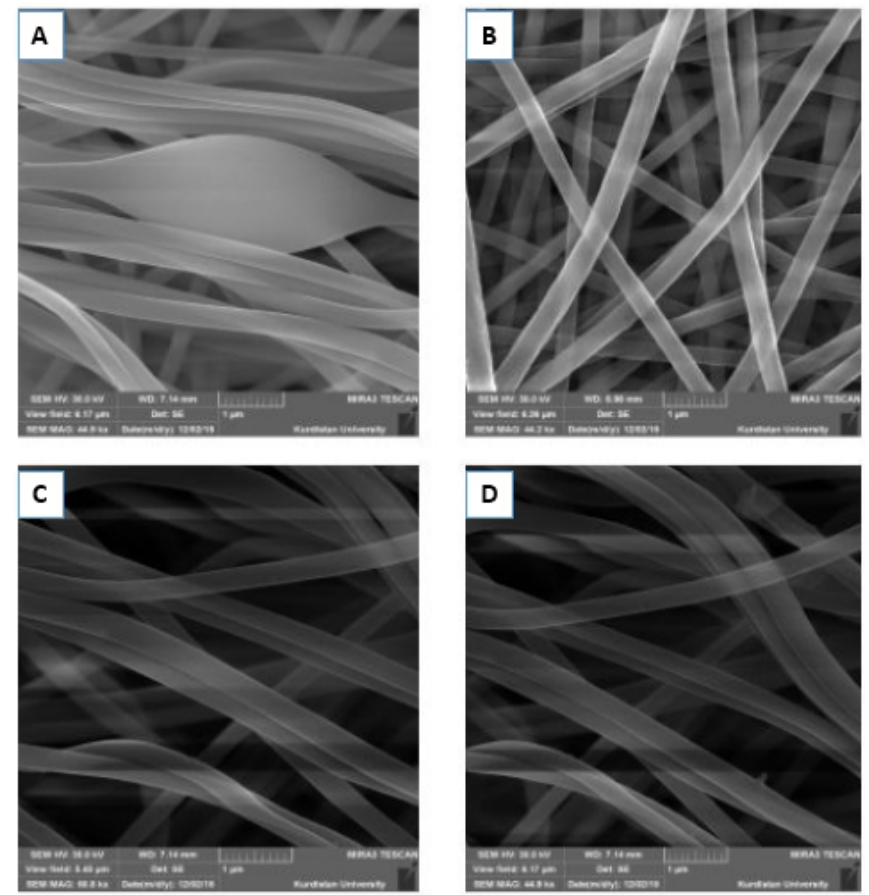
Fig. 1. SEM images of pure PAN nanofibers with a PAN loading (A) 8 wt%, (B) 10 wt%, (C) 12 wt%, zand (D)